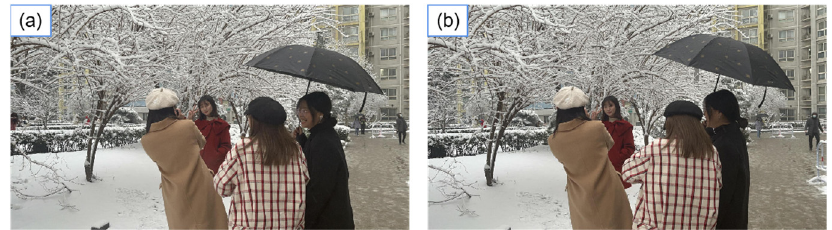
Figure 21. Generated caption: ( a ) “a group of people standing in the snow”; ( b ) “three people are standing in front of a brick wall”.